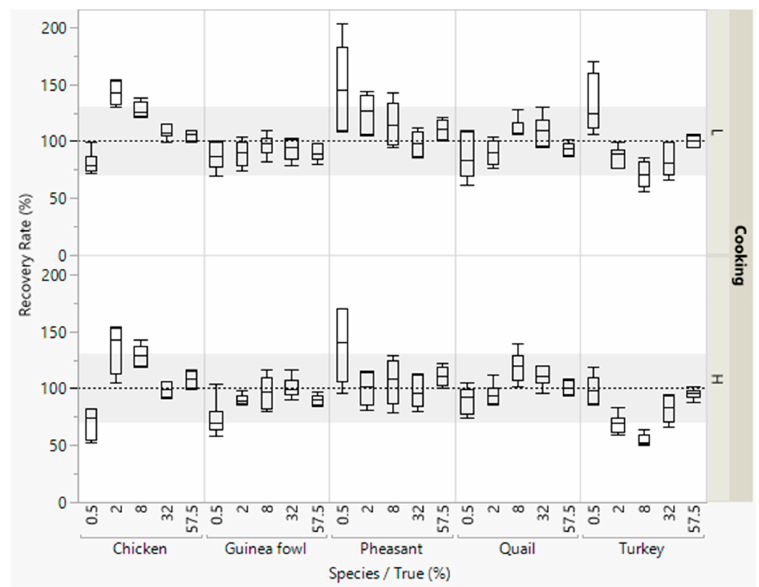
Figure 2. Recovery rates of meat from five poultry species in emulsified type sausages (with 0.5–57.5% meat) quantified with pre-defined multiplication factors. All concentration levels were cooked at low